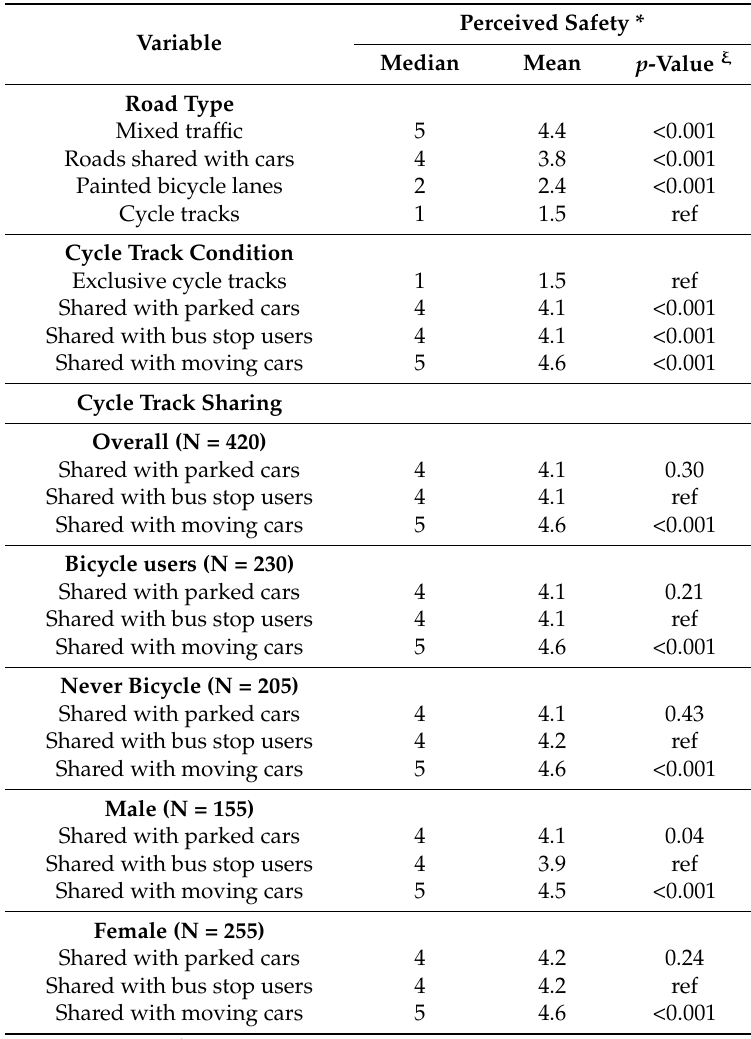
Table 2. Perceived safety of road type, cycle track conditions, cycle track sharing-comparison overall, bicycle use and